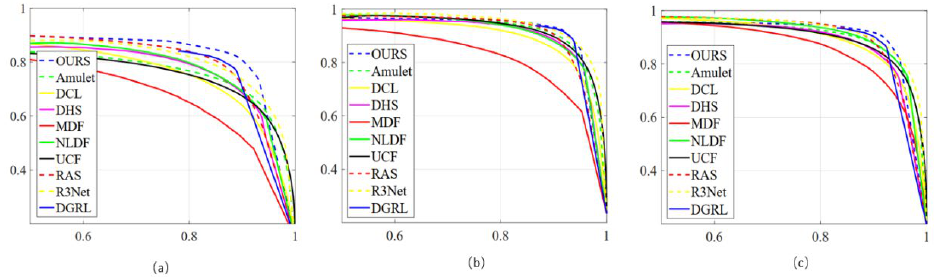
Figure 8. The P-R curves of each method according to different datasets. ( a ) the P-R curves of the individual algorithm on the DUTS dataset; ( b ) the P-R curves of each model on the ECSSD dataset; ( c ) the P-R curves of diverse approaches on the HKU-IS dataset.